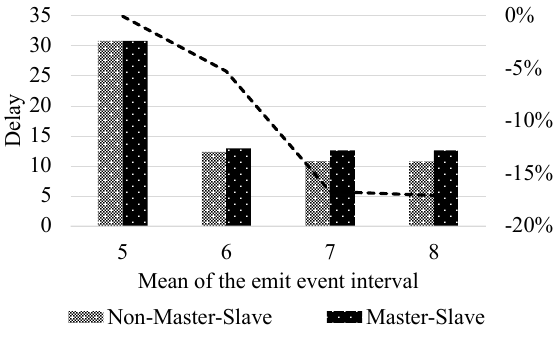
Figure 8. Total delay of the